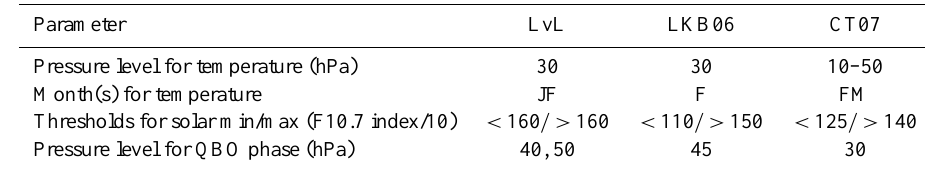
Table 1. Choice by different authors of various parameters used in studies of the influence of solar variability and the QBO on Northern Hemisphere winter polar